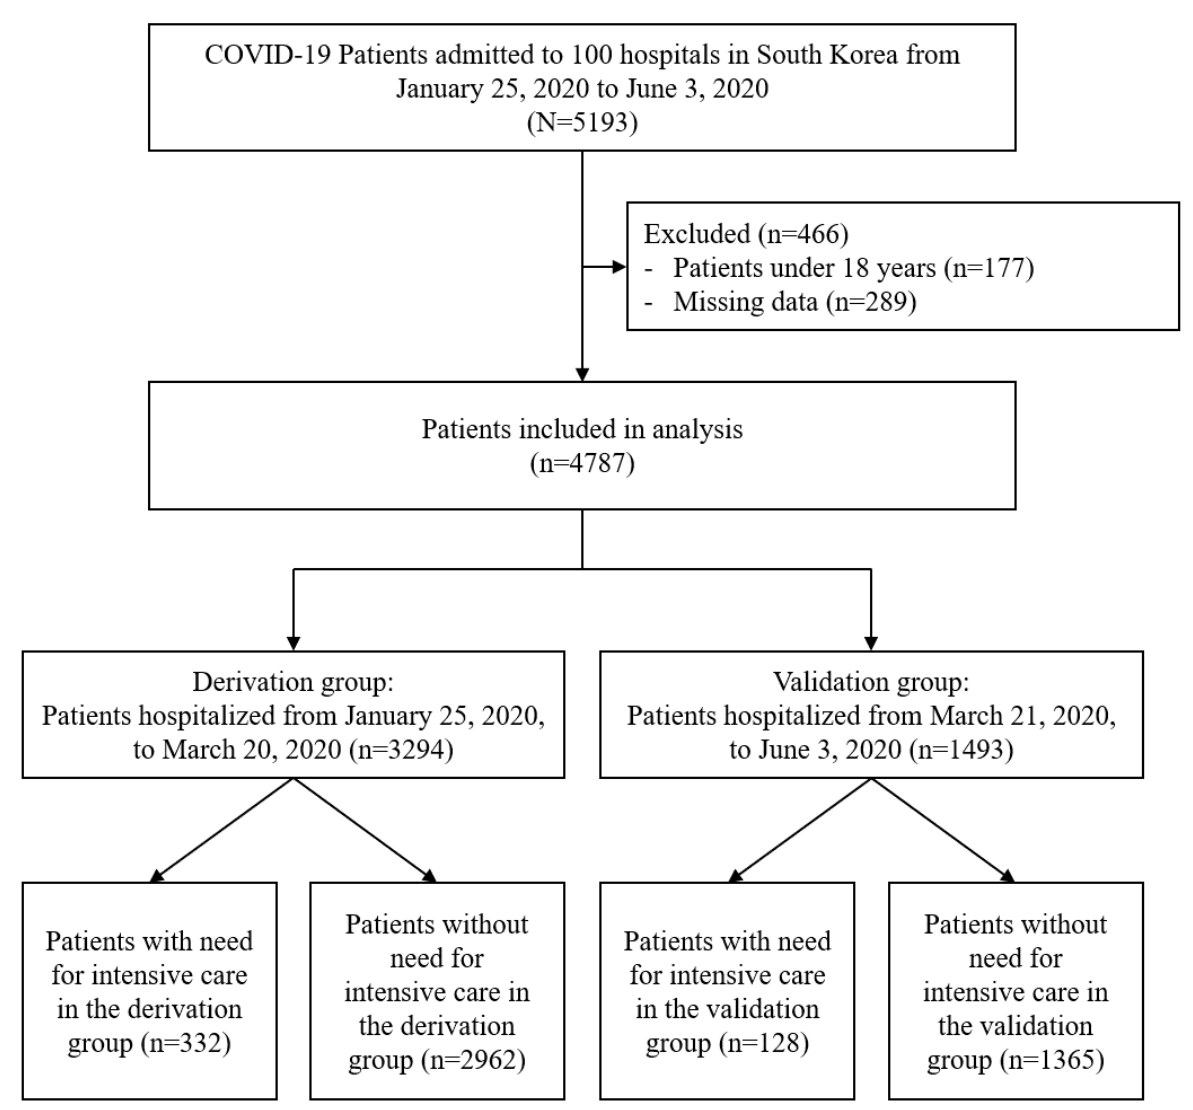
Figure 1. Flowchart of the patient selection process. Patients hospitalized in 100 hospitals in South Korea from January 25, 2020, to June 3, 2020, were included. Patients who were admitted until March 20 were assigned to the derivation group, and those hospitalized after March 21 were assigned to the validation